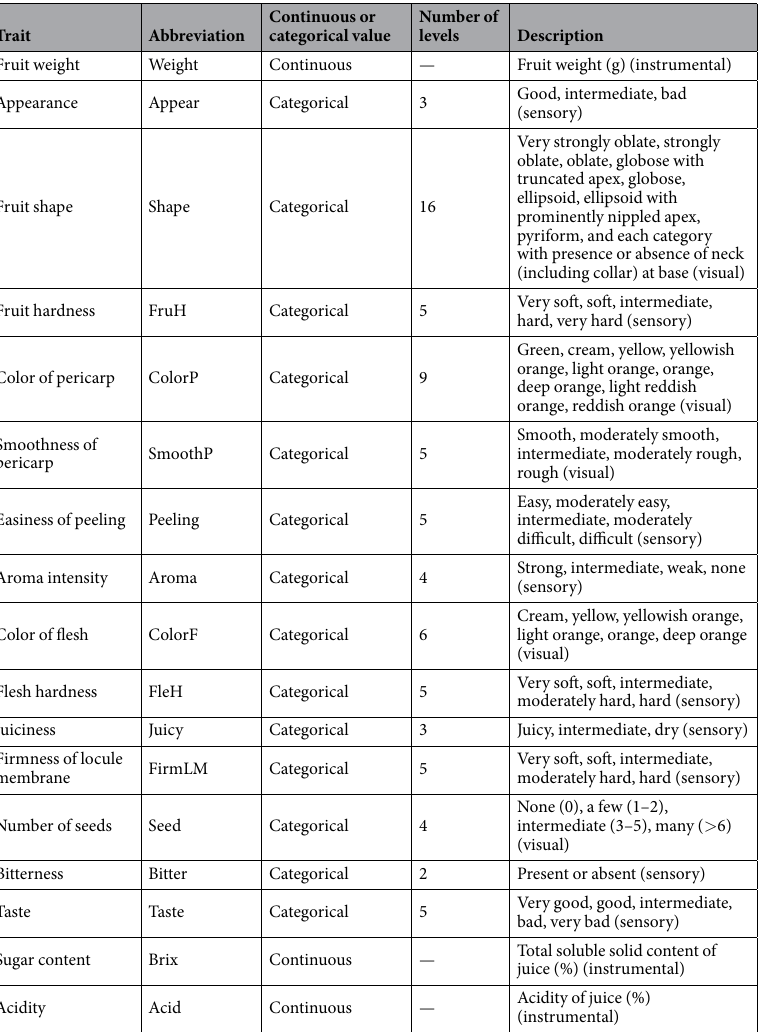
Table 1. Fruit quality traits evaluated in this